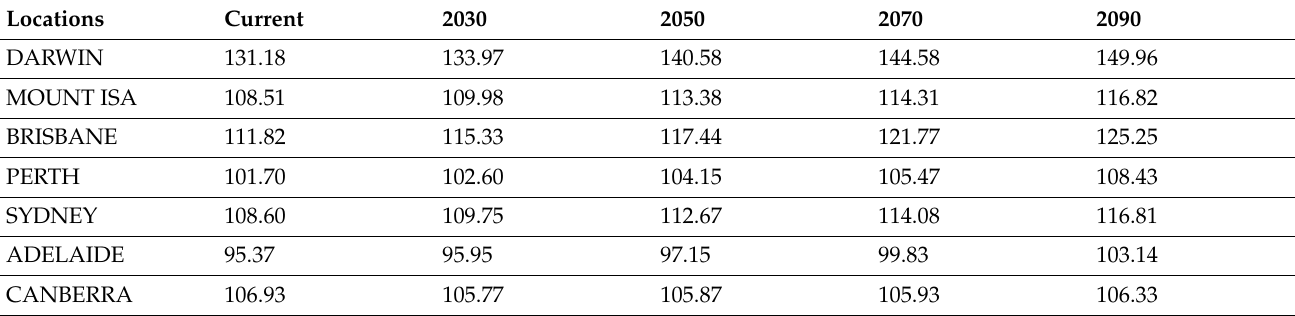
Table 12. Large hospital’s yearly HVAC energy use in kWh/m 2 .